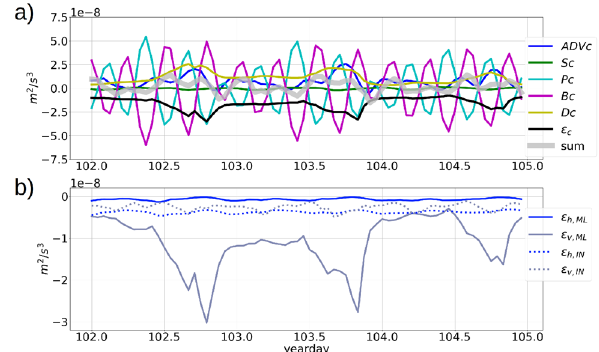
Figure 10. ( a ) Components of the transport equation of the depth-averaged E BCK (Eq. B11) over 3 consecutive days in April, averaged over the entire domain excluding the sponge layer. The gray curve denotes the net tendency, which is the sum = Pc + Bc + Dc + ǫ c − ADVc − Sc . ( b ) Horizontal ( ǫ h ) and vertical ( ǫ v ) components of the parameterized dissipation ( ǫ c ) of E BCK , averaged over the MLD , and averaged over the interior depth ( IN ) which is from the topographic depth to the ML base.